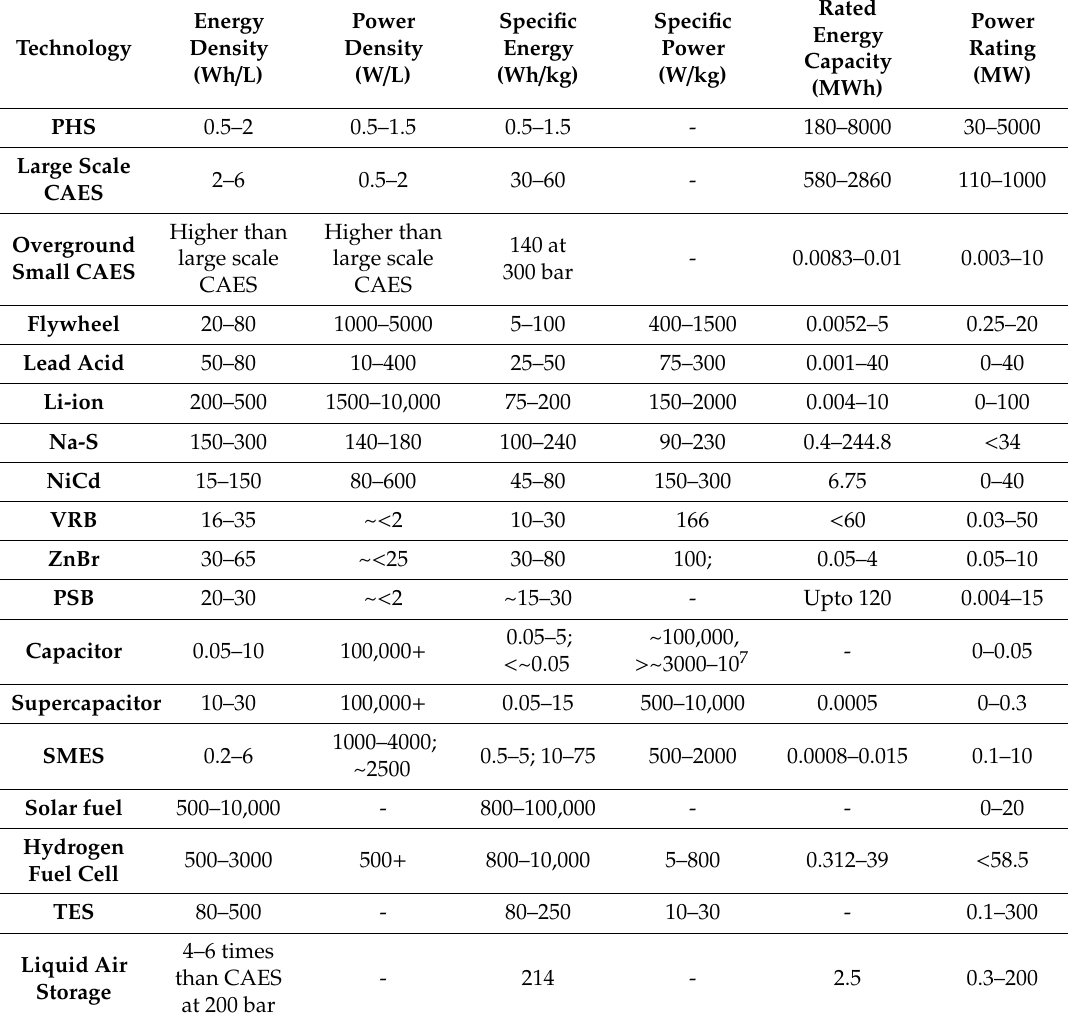
Table 14. Comparison of the technical parameters of di ff erent energy storage systems—I [26].